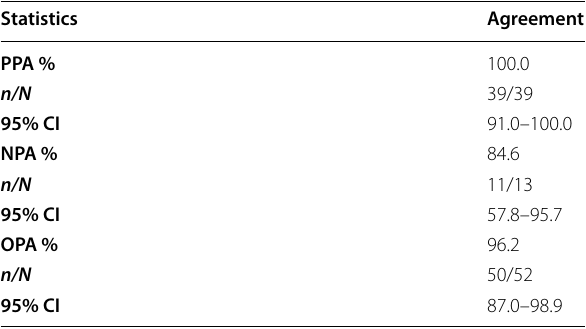
Table 4 Agreement between TAP (1% cutoff) and CPS (cutoff of 1) scoring algorithms